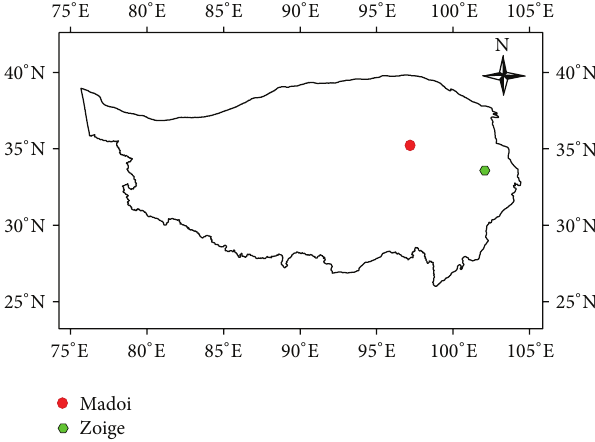
Figure 1: The Tibetan Plateau (TP), the locations of the Madoi site and the Zoige